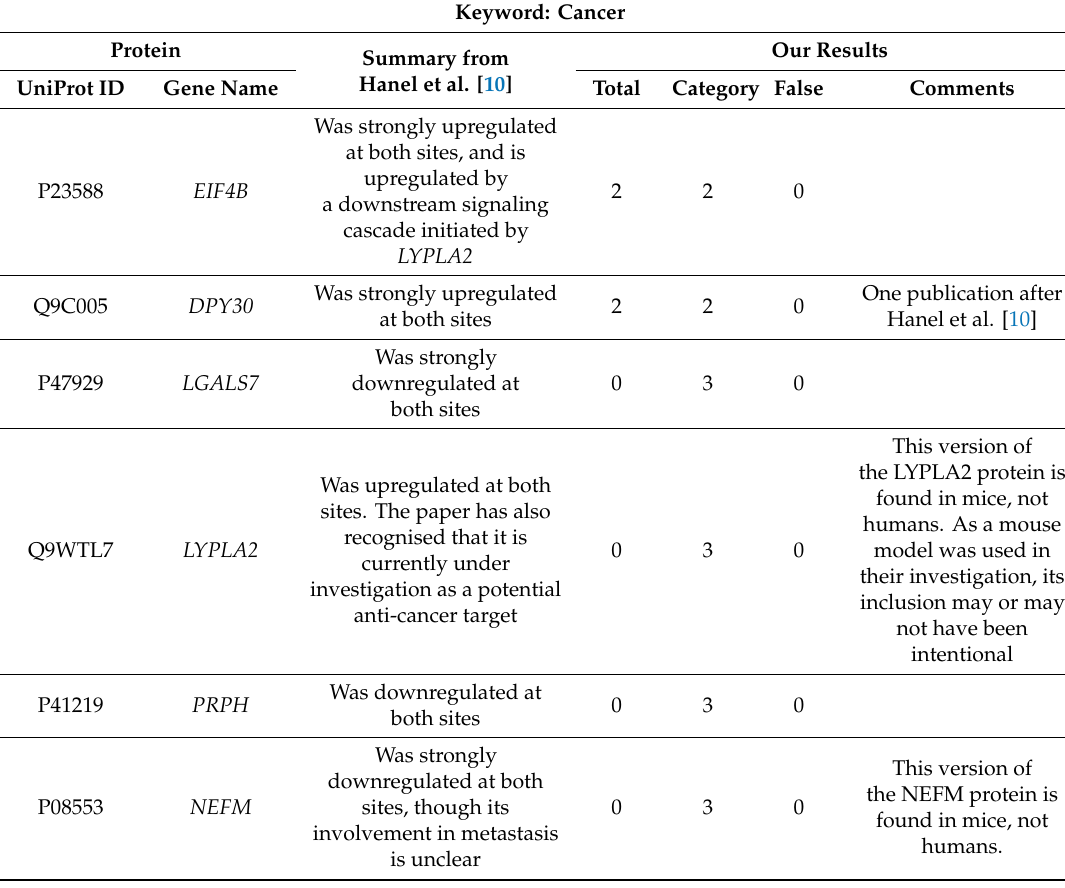
Table 2. Extract of the OmixLitMiner output of the di ff erentially expressed proteins at both distant sites compared to the primary tumour as reported in the supplement of Hanel et al. [10] using the keyword